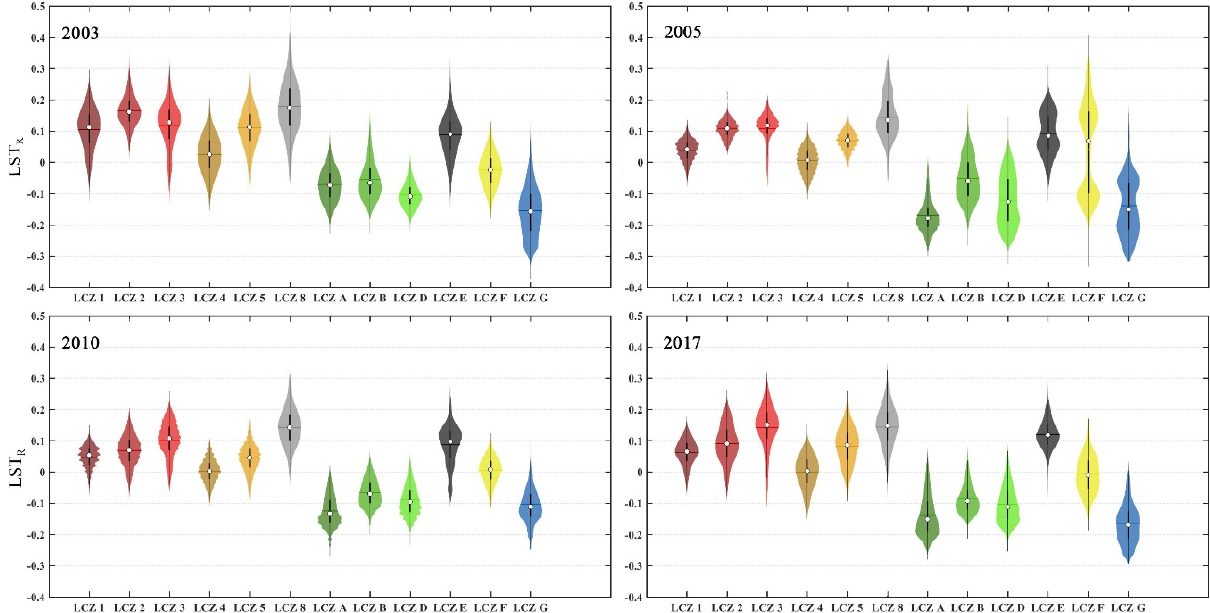
Figure 10. The statistical results of distribution of LST R of each LCZ type in 2003, 2005, 2010 and 2017.